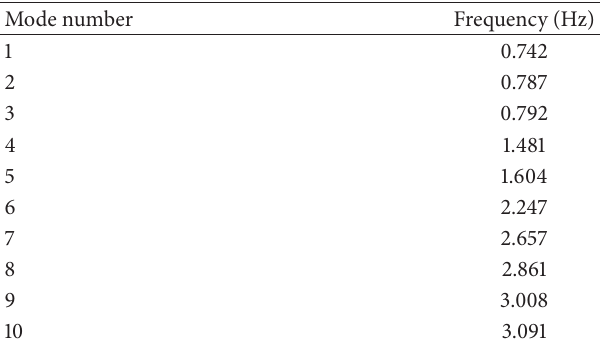
Table 2: Calculated natural frequencies of JZ20-2MUQ platform